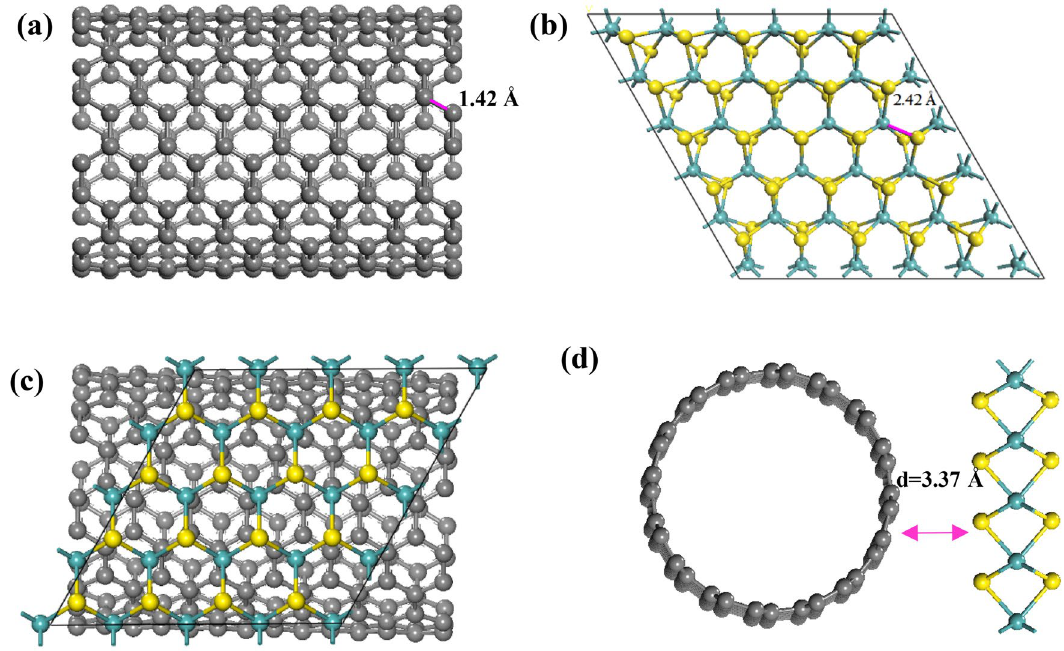
Figure 1. The most stable configurations of: ( a ) CNT; ( b ) MoS 2 ; ( c ) top view of MoS 2 /CNT; and ( d ) side view of MoS 2 /CNT. Gray, green and yellow spheres stand for C, Mo and S atoms,